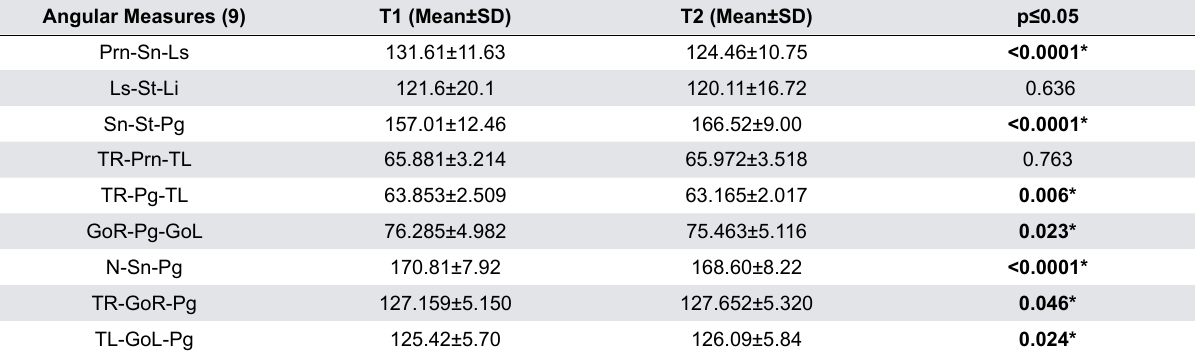
Table 2- Comparative analysis of angles (degrees) in both timestamps, T1: without complete dentures and T2: with conventional maxillary and mandibular complete dentures in all participants